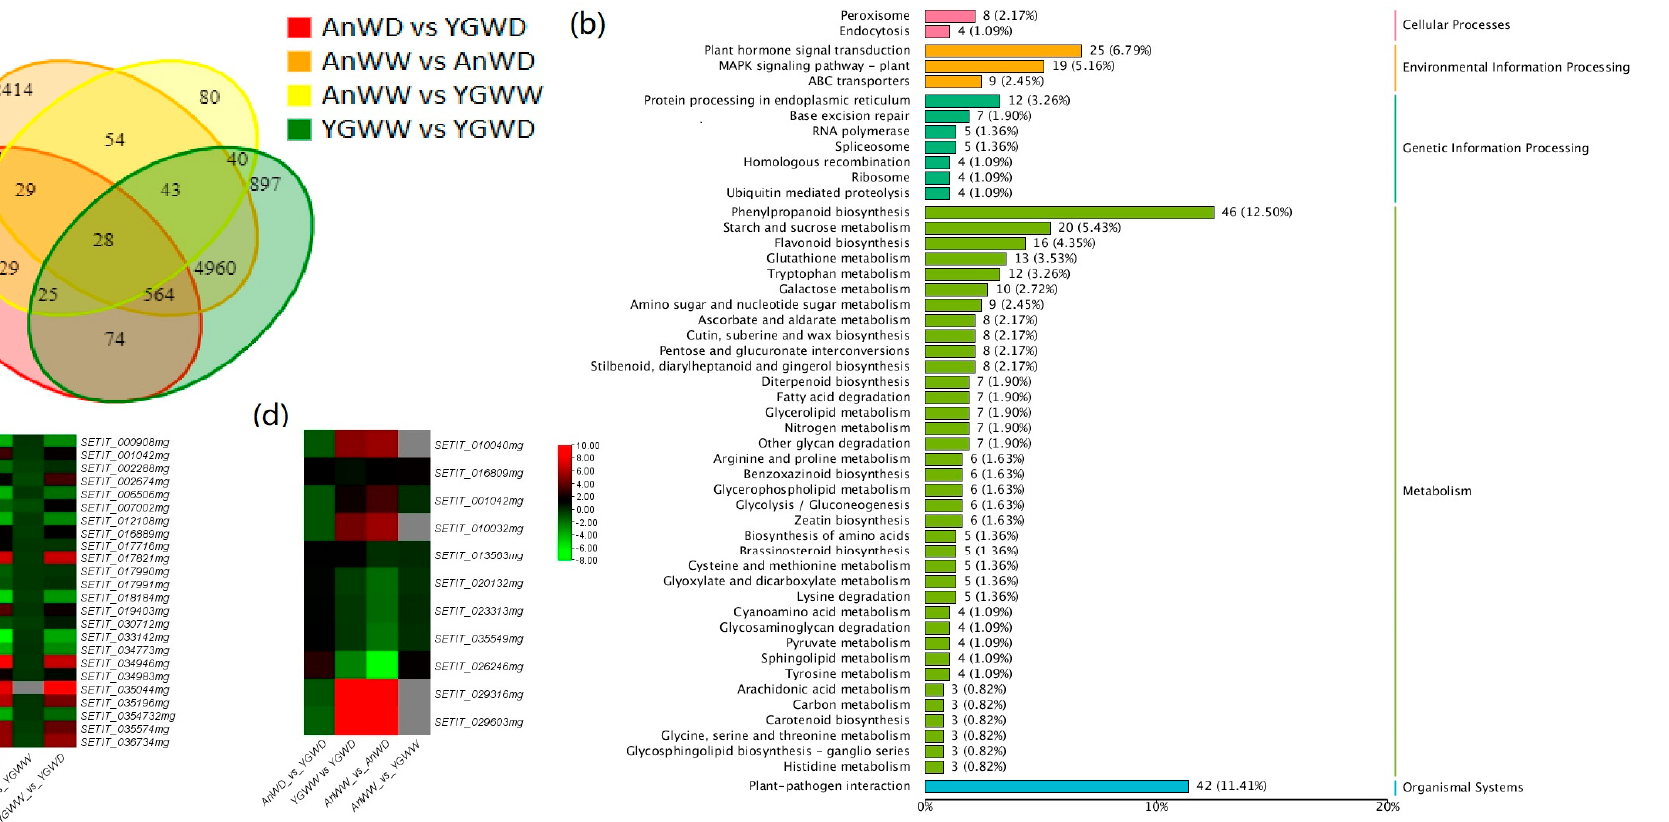
Figure 4. Gene transcription analysis of the two cultivars: ( a ) Venn diagrams of the DEGs between the groups. The different color indicates NO. of DEGs between different treatment, e.g., red color shows DEGs between An and YG under WD condition; ( b ) KEGG category; ( c ) a heatmap of the partial DEGs involved in carbohydrate transport and metabolism; ( d ) a heatmap of the partial DEGs involved in secondary metabolite biosynthesis, transport, and catabolism.